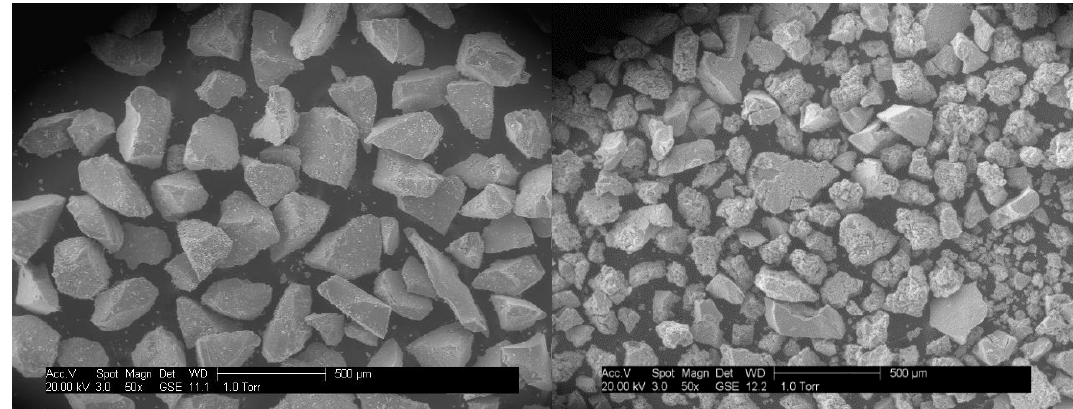
Figure 13. SEM images of calcined fresh ( left ) and used ( right ) 0La catalyst. The images show a change in particle size distribution after the catalyst was exposed to reaction conditions.